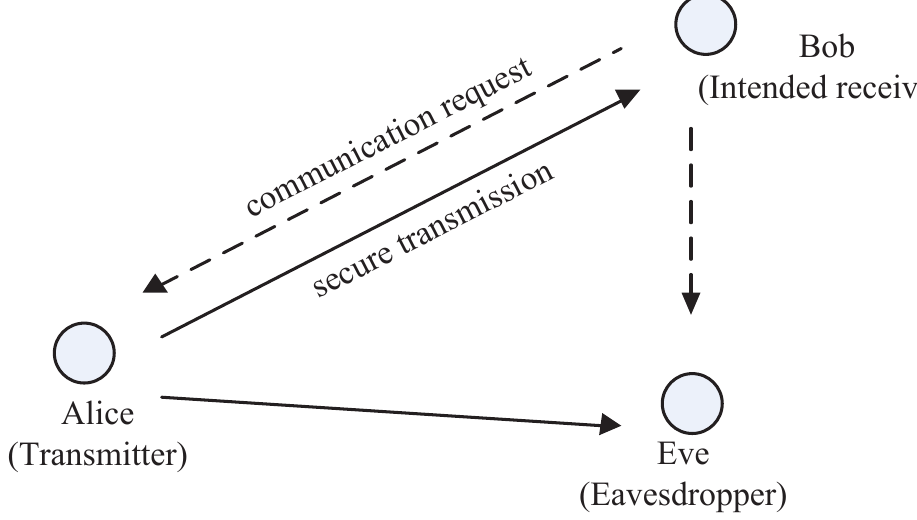
Figure 4. Secure communication system